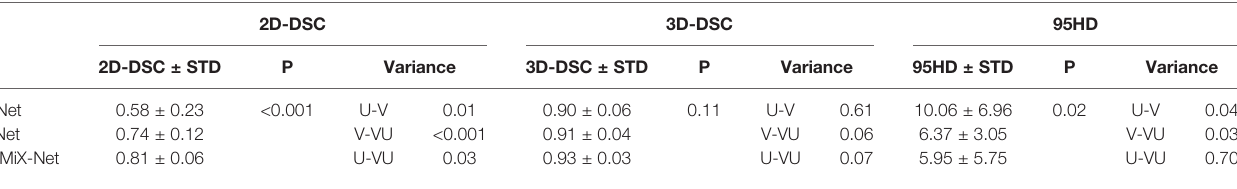
TABLE 3 | 2D-DSC, 3D-DSC, and 95HD values of the GTV contours in upper and middle esophageal cancer (EC) patients predicted from U-Net, V-Net, and